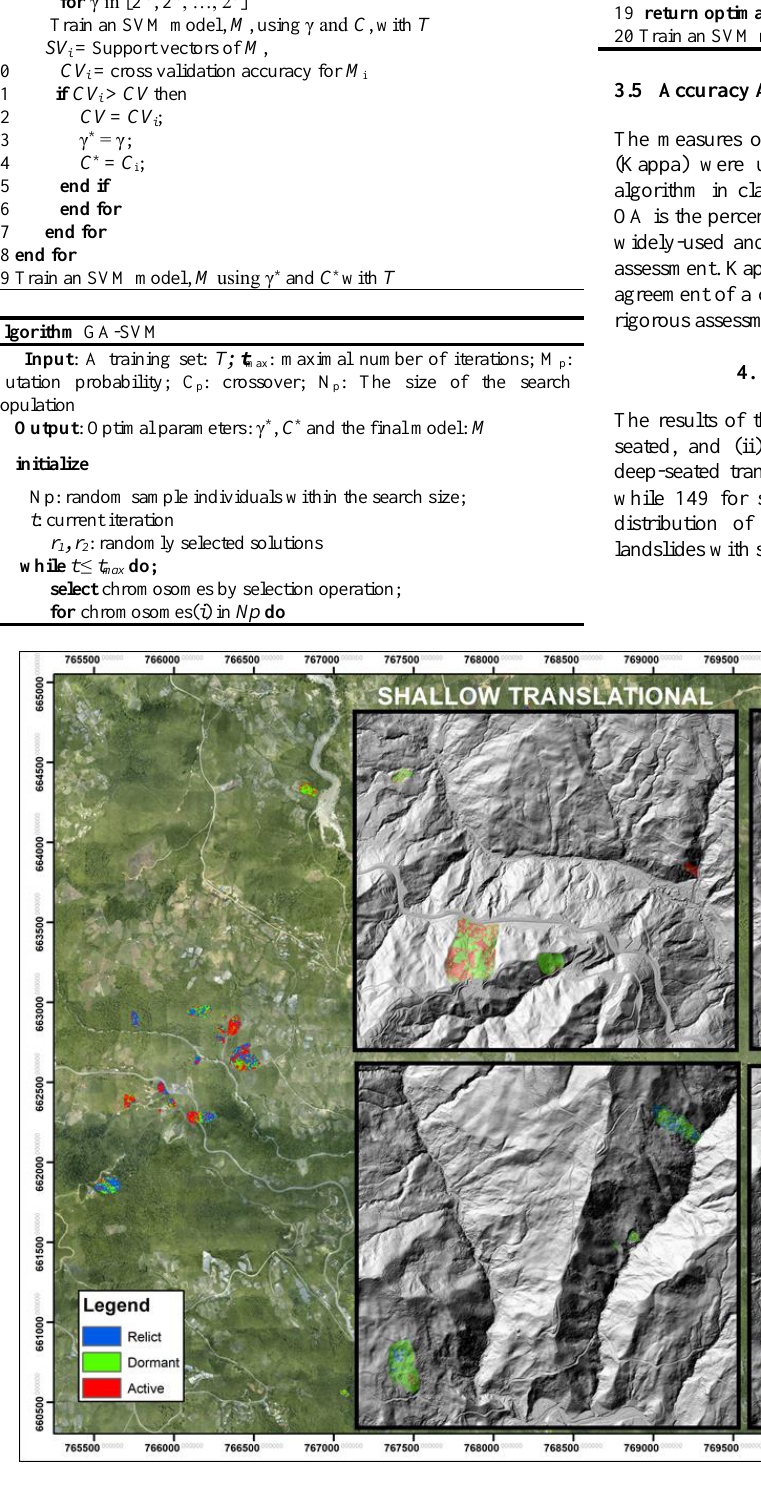
Figure 2 . Distribution of translational landslide with classified activity from the modelling